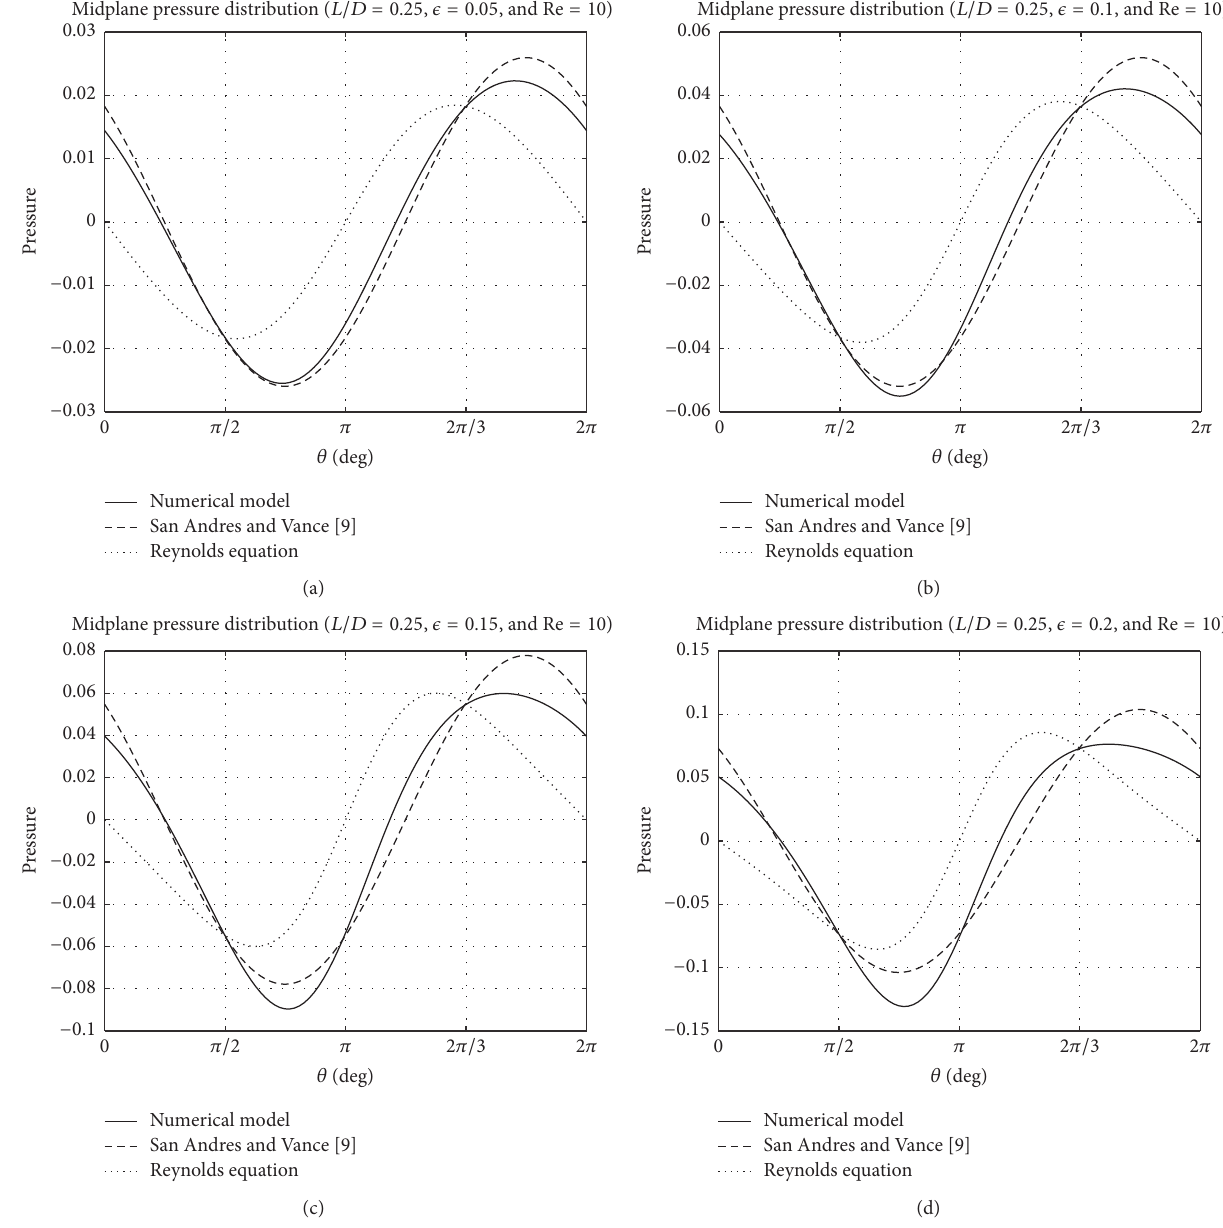
Figure 4: The effect of SFD journal eccentricity ratio on the dimensionless pressure